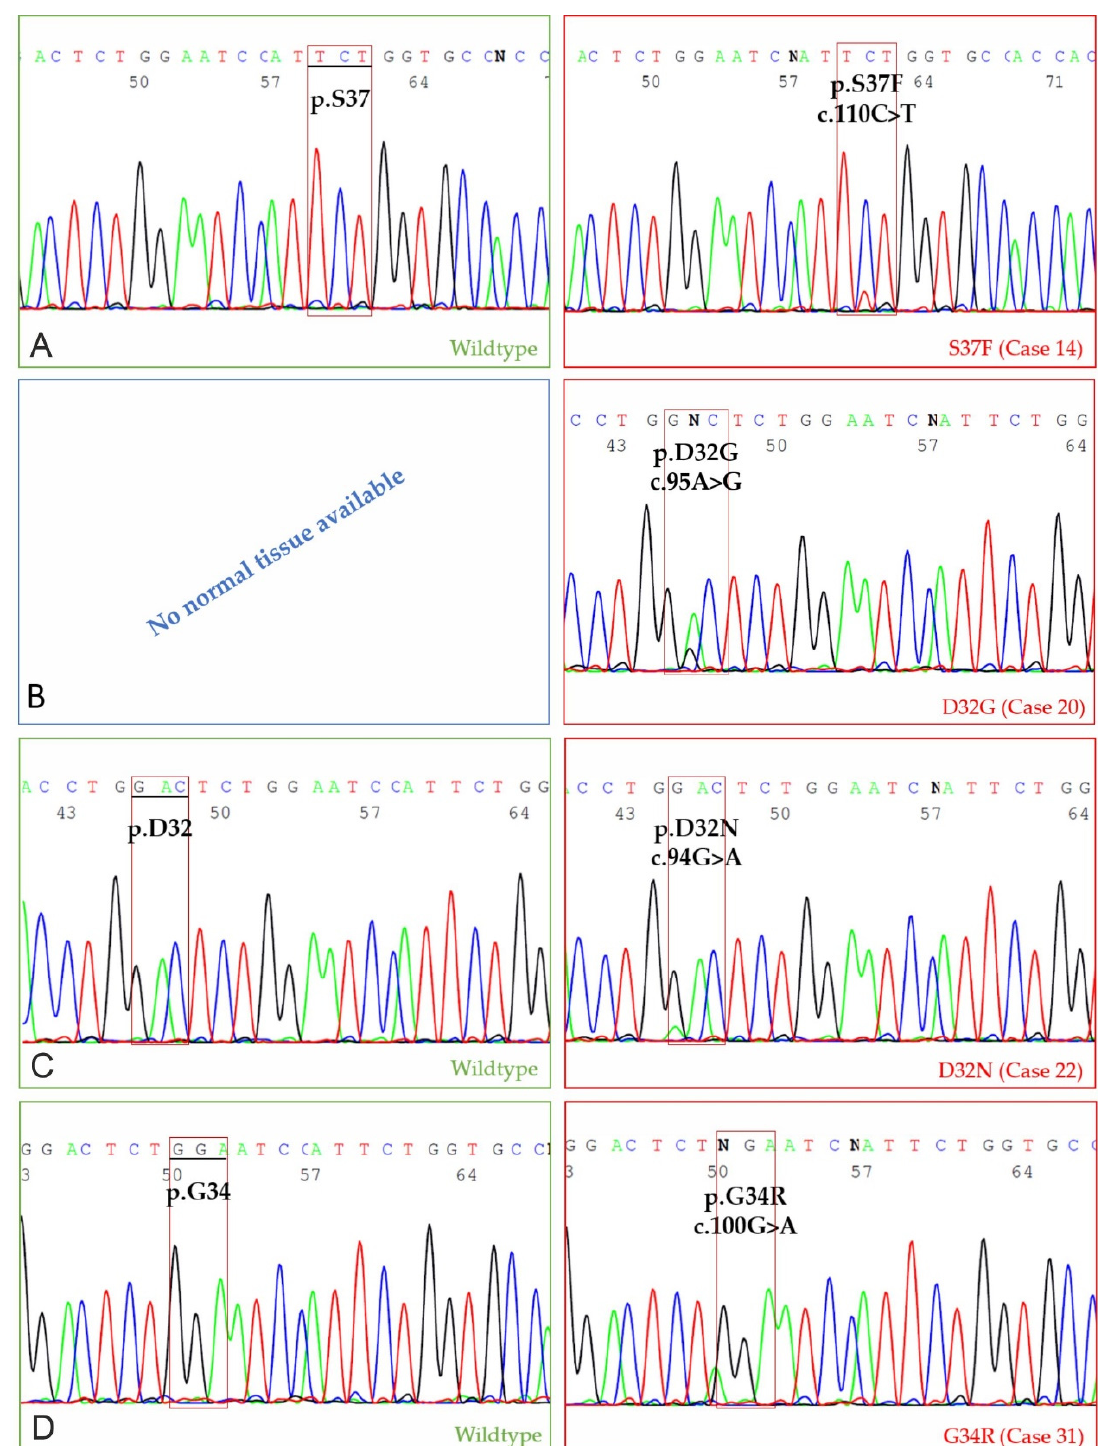
Figure 6. Four distinct somatic missense mutations were detected, each of them in a different case. DNA forward sequences; green: wildtype sequence of normal intestinal tissue ( n = 3); red: tumor Table S4. ( A ) Cytosine (C) is substituted by Thymine (T), resulting in a missense mutation leading to a replacement of Serine (S) by Phenylalanine (F) on the protein level (colonic ANOS; β -catenin score 1); ( B ) Adenosine (A) is substituted by Guanin (G) resulting in a missense mutation leading to a replacement of Aspartic acid (D) by Glycine (G) (colonic ANOS; score 3). For case 20, no normal tissue was available; ( C ) Guanin (G) is substituted by Adenosine (A) resulting in a replacement of Aspartic acid (D) by Asparagine (N) (colonic ANOS, score 1); ( D ) Guanin (G) is substituted by Adenosine (A) resulting in a replacement of Glycine (G) by Arginine (R) (colonic SAC, score 1).